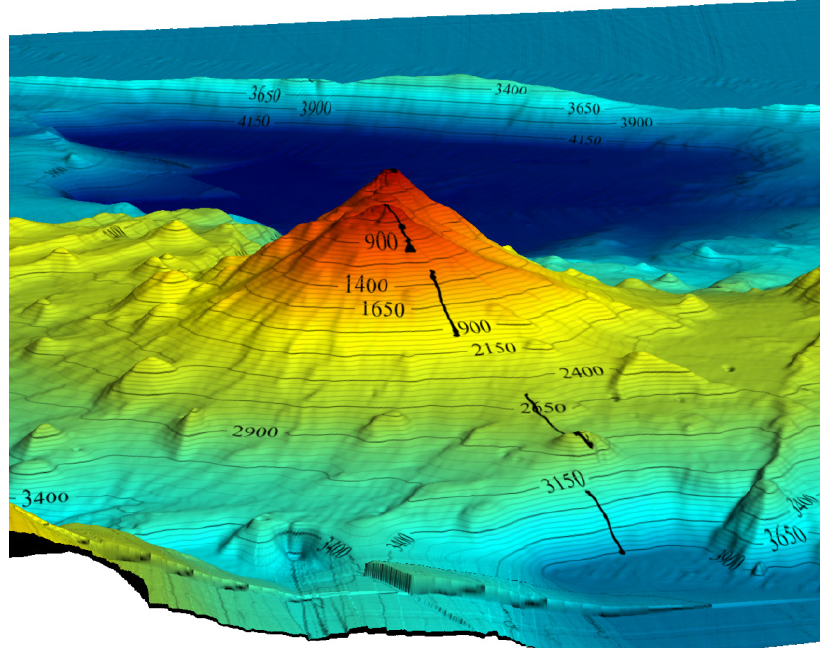
Figure 8. A model for the Piip Seamount and tracks of the ROV’s movements.